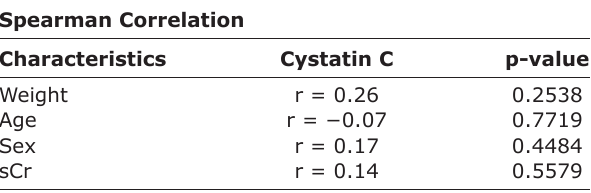
Table-3: Spearman correlations among sCy, body weight, age, and sex of the control animals (n = 19). Spearman Correlation Characteristics